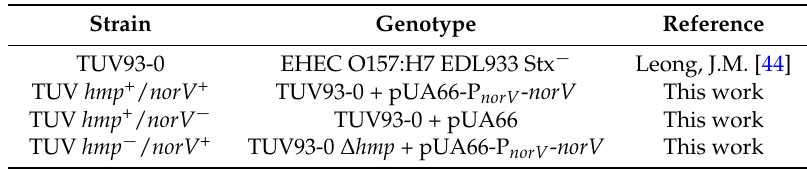
Table 1. E. coli strains used in the present